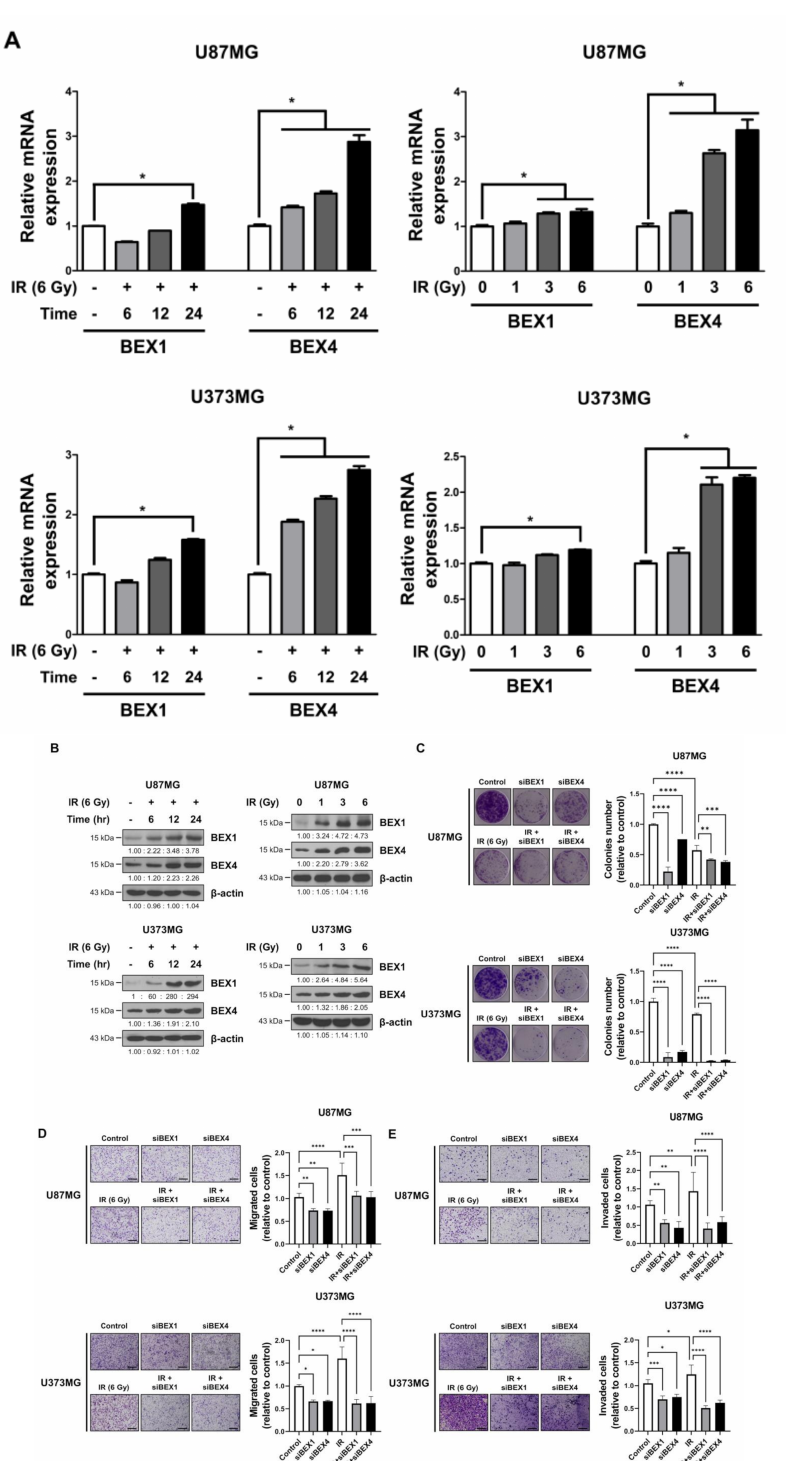
Figure 2. BEX1 and BEX4 increase migration and invasion of GBM. ( A , B ) The time- or dose-dependent alterations in the mRNA and protein expression levels of BEX1 and BEX4 after irradiation in U87MG and U373MG were assessed by qRT-PCR and Western blot analysis. ( C ) The proliferation of U87MG and U373MG cells after knockdown of BEX1 or BEX4 with/without irradiation was assessed by clonogenic assay, and the colonies were counted by openCFU software ( n = 3). ( D , E ) The migration and invasion ability of U87MG and U373MG cells after knockdown of BEX1 or BEX4 with/without irradiation was assessed by Transwell migration or invasion assay and quantified by ImageJ ( n = 3). Statistical analysis was performed with one-way ANOVA plus a Tukey’s multiple comparisons test. * p < 0.05, ** p < 0.01, *** p < 0.001, **** p <